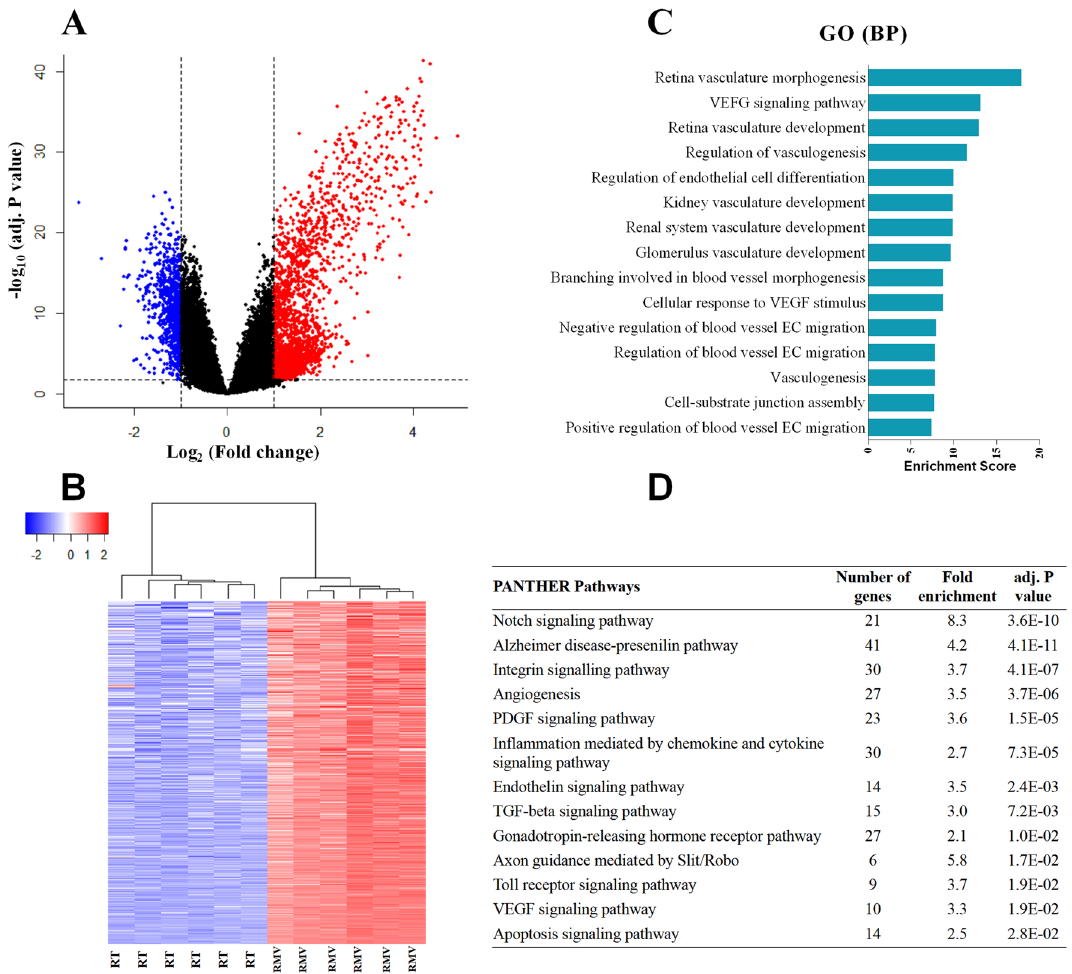
Figure 2. Gene expression comparison between retinal microvessels (RMVs) and retinal tissue (RT) in rats (n = 6). (A) Volcano plot for the RMVs versus RT whole transcriptomes. The red dots indicate the genes that are significantly higher expressed (fold change [FC] ≥ 2.0 and adjusted p < 0.05) in RMVs compared to RT, while blue dots indicate the lower expressed genes (FC < -2.0 and adjusted p < 0.05). (B) Hierarchical cluster analysis for genes that are significantly enriched (FC > 2.0 and adjusted p < 0.05) in RMVs. (C,D) Top 15 gene ontology (GO) biological processes (BP) and top 12 PANTHER pathways identified from the RMVs enriched genes. All the biological processes shown are ranked by enrichment score with a Bonferroni adjusted p <